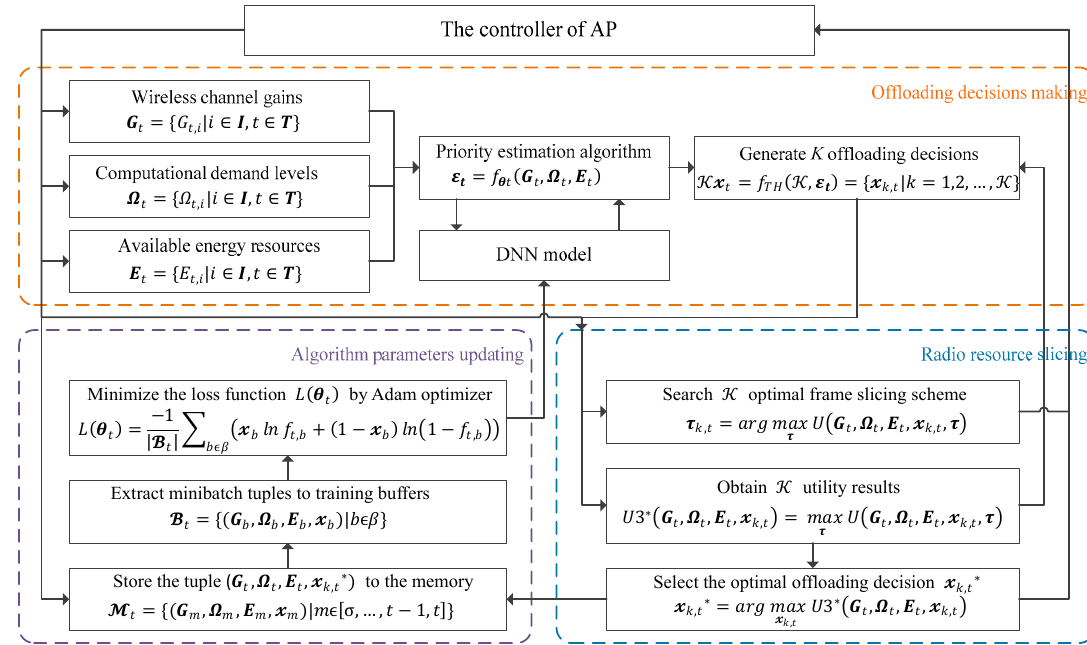
Figure 2. Iterated learning-based framework of intelligent rapid adaptive offloading (IRAO).